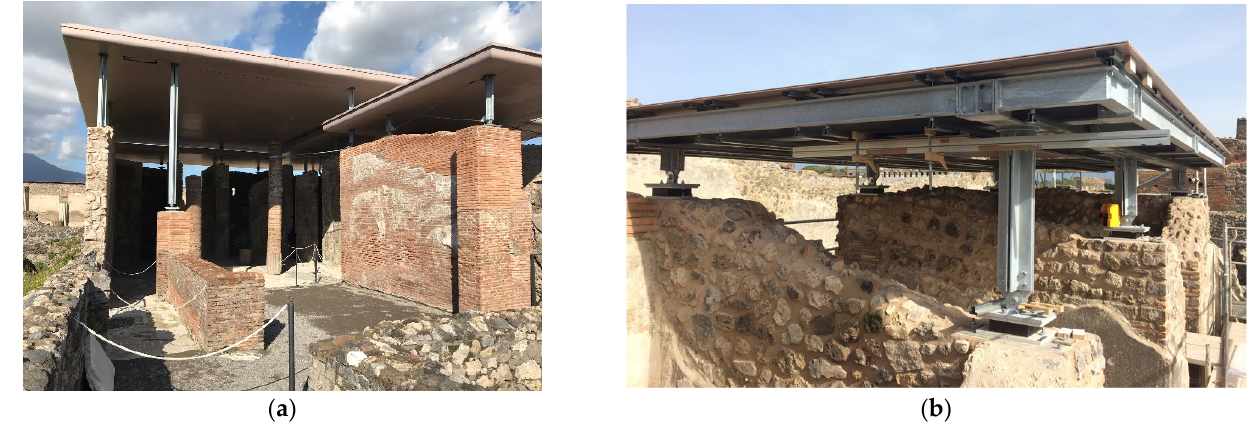
Figure 4. The new roof in the Championnet area. ( a ) View of the new roof. ( b ) Steel structures before coating.